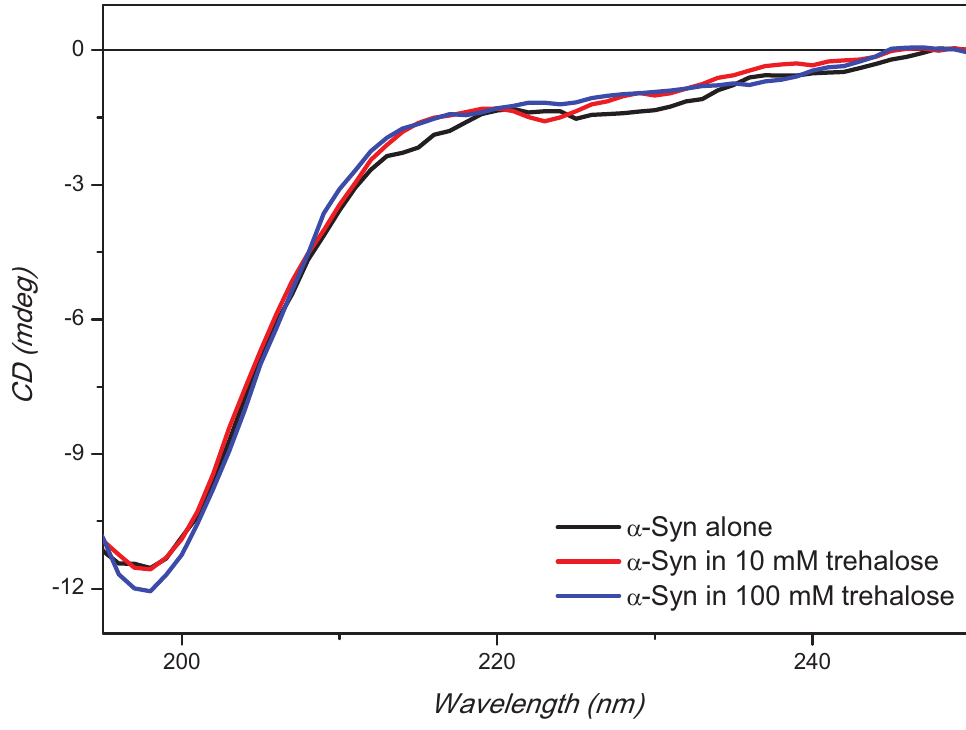
Figure 2. Far-UV synchrotron radiation circular dichroism (SRCD) spectra of (cid:2)-synuclein alone or in presence of 10 or 100 mM trehalose. (cid:2)-Synuclein concentration was 0.36 mg/mL in PBS buffer, pH